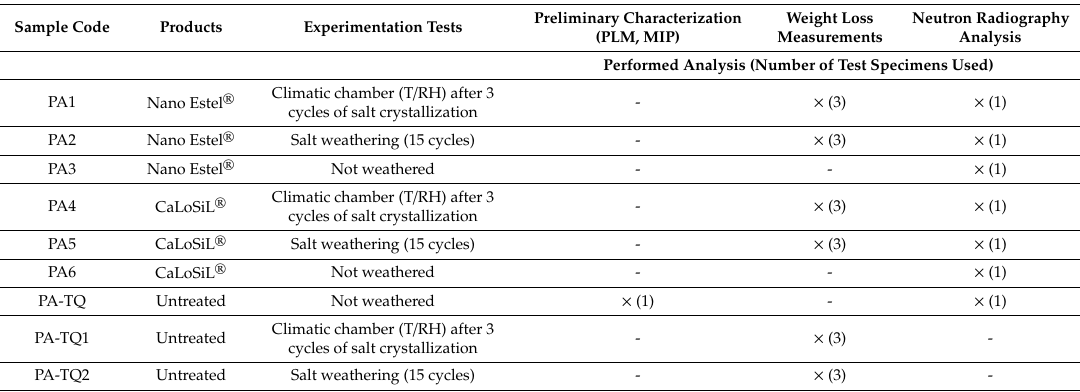
Table 1. List of all the investigated specimens together with details about products and experimentation tests. PLM, polarized light microscopy; MIP, mercury intrusion porosimetry; T, temperature; RH, relative